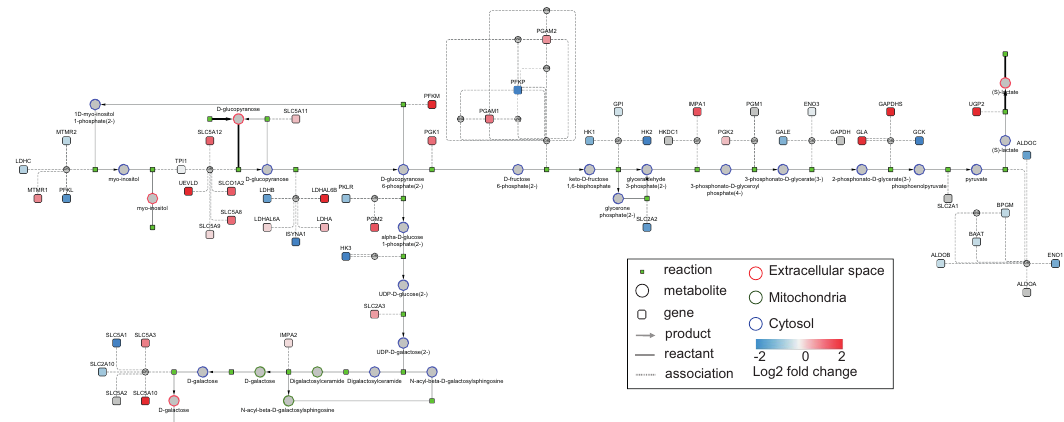
Figure 4. EFM from Recon 2.2 that takes up glucose and releases lactate. This EFM had the highest density of reactions in glycolysis/gluconeogenesis and galactose metabolism. The uptake and release reactions are highlighted in black. Metabolite node colors indicate the intracellular location, extracellular space (red), cytosol (blue) and mitochondria (green). Changes in gene expression between breast cancer tumor and healthy tissue (log2 fold change) have been mapped on the genes. Using this NDEx link, http://bit.ly/39tf1Ub, the network can be studied